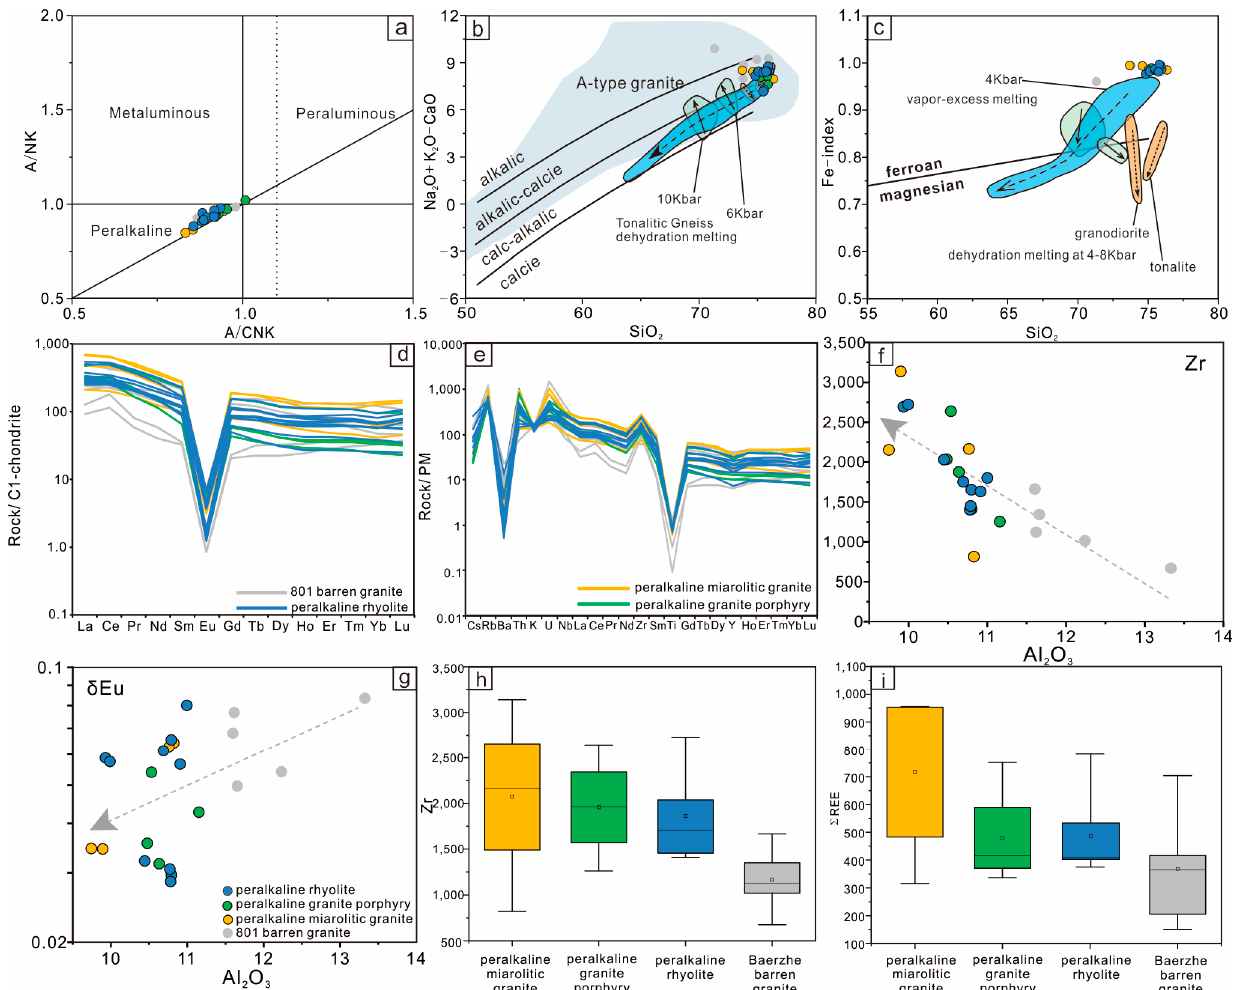
Figure 5. ( a ) A/NK (molar Al 2 O 3 /(Na 2 O + K 2 O)) versus A/CNK (molar Al 2 O 3 /(CaO + Na 2 O + K 2 O)); fields after Shand [53] for studied samples; ( b ) Na 2 O + K 2 O-CaO (wt%) versus SiO 2 (wt%); fields after Frost and Frost [54]; ( c ) Fe-index ((FeO + 0.9Fe 2 O 3 )/(FeO + 0.9Fe 2 O 3 + MgO)) versus SiO 2 (wt%); fields after Frost and Frost [54]; ( d ) Chondrite-normalized REE patterns of the peralkaline granitic rocks and ( e ) Primitive mantle-normalized multi-element variation diagrams of the per- alkaline granitic rocks; the normalization values for primitive mantle and chondrite are from Sun and McDonough [55]; ( f ) Zr versus Al 2 O 3 and ( g ) δ Eu versus Al 2 O 3 for the peralkaline granitic dikes and Baerzhe barren granite; Box chart of Zr ( h ) and Σ REE ( i ) of the peralkaline granitic dikes and Baerzhe barren granite (Horizontal line within the box and square represent median and mean respectively); data sources of the Baerzhe barren granite: Bor-ming Jahn [20]; Yang, Shan [26]; Su, Jiang [24], the following are the same.